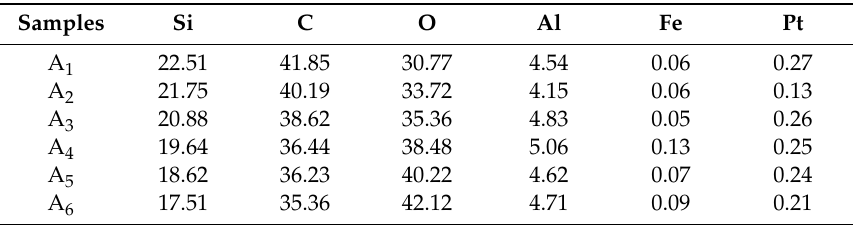
Table 6. Main element contents (%) of composite insulators of Factory